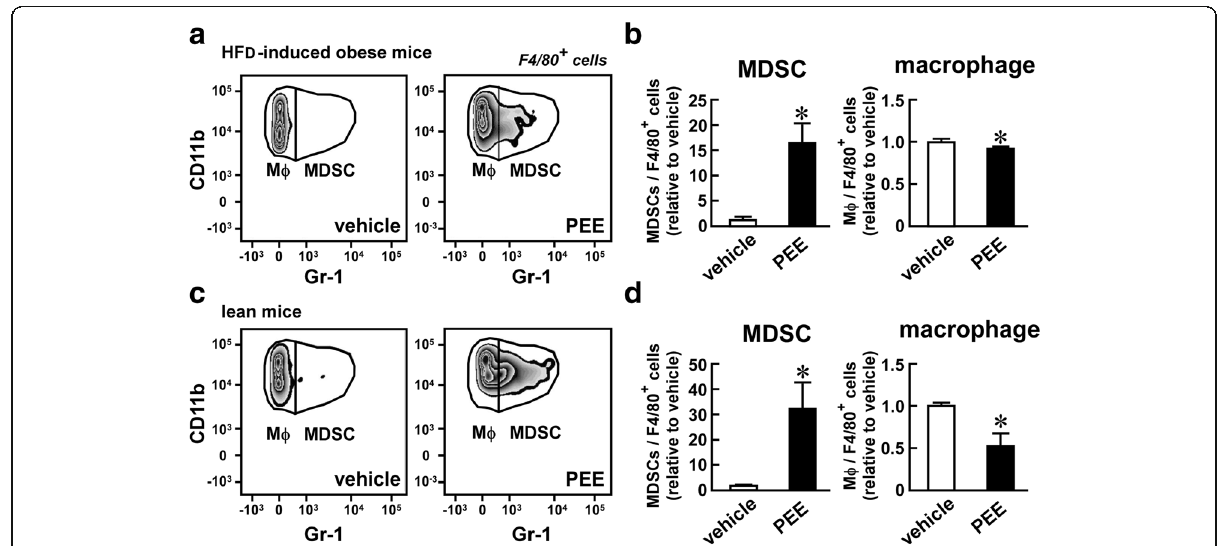
Fig. 4 Effects of PEE on the number of macrophages and MDSCs in the peritoneum of HFD- and normal chow-fed mice. C57BL/6 mice were fed with ( a , b ) HFD or ( c , d ) normal chow. PEE (100 mg/kg, twice weekly) or vehicle was intraperitoneally injected into the mice for one month. Cells in the peritoneal cavity were harvested and subjected to FACS analysis for macrophages and MDSCs. a , c Representative FACS images of four replicates. Only F4/80 + living cells are shown. b , d Proportion of macrophages and MDSCs in F4/80 + myeloid cells in the peritoneum of ( b ) HFD-fed and ( d ) normal chow-fed mice. Data represents means ± SD of four samples. * P < 0.05 vs. vehicle-treated